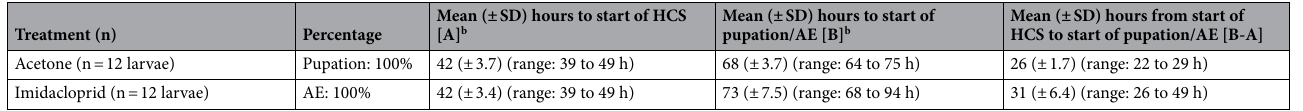
Table 1. Time to head capsule slippage and pupation or arrested pupal ecdysis for corn earworm sixth instars topically treated with acetone or 20 µg imidacloprid a . HCS head capsule slippage, AE arrested (pupal) ecdysis, SD standard deviation. a Larvae were approximately 2-day old sixth instars at the time of treatment. b Hours to HCS and pupation/AE were calculated from time of